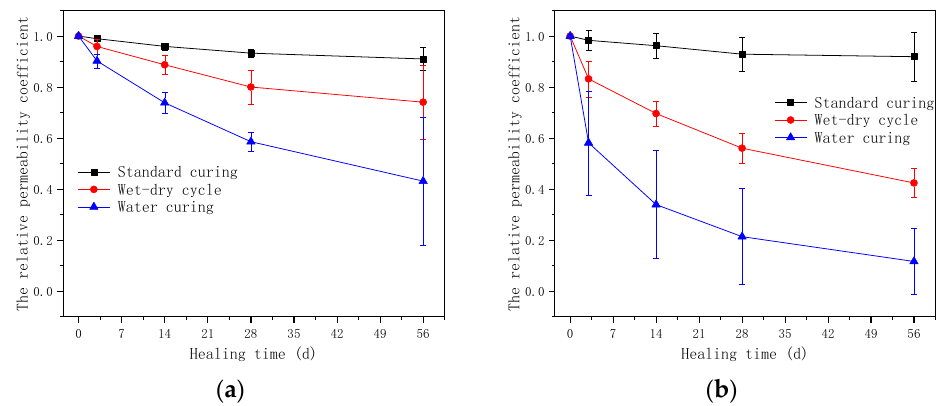
Figure 5. The relative permeability coefficient of mortar specimens under different exposure environments: ( a ) control; ( b ) with bacteria. Three specimens were tested for each exposure environment.